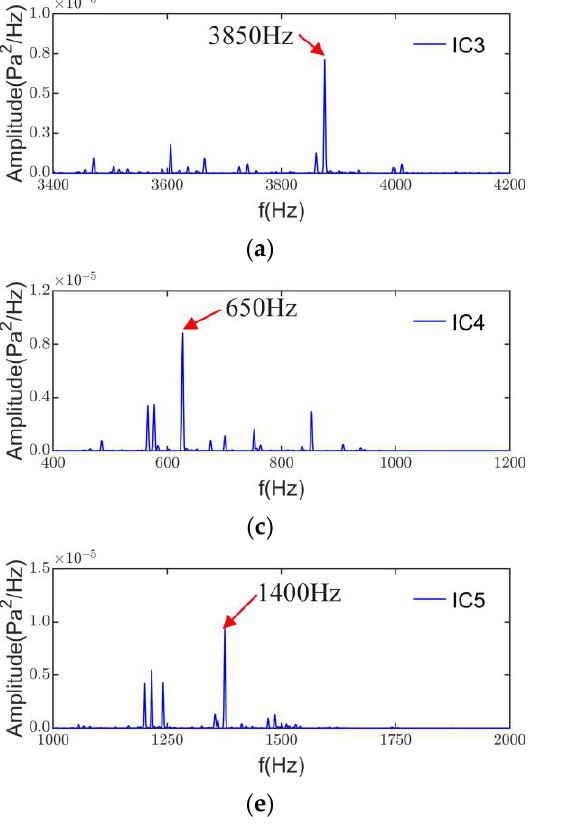
Figure 17. PSD and envelope spectrum of IC3-IC5: ( a ) PSD of IC3; ( b ) envelope spectrum of IC3; ( c ) PSD of IC4; ( d ) envelope spectrum of IC4; ( e ) PSD of IC5; ( f ) envelope spectrum of IC5.